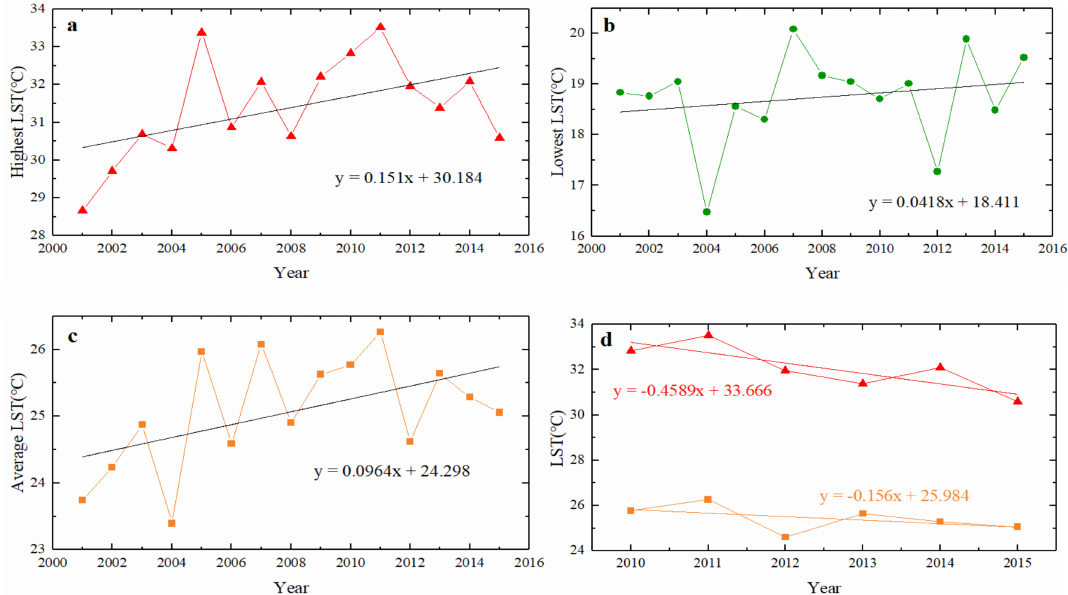
Figure 8. The change of LST ( ◦ C) in Chongqing City. ( a ), ( b , c ) represent the highest, lowest and average LST changes, respectively, from 2001 to 2015. ( d ) represents the changes of highest LST (the red line) and average LST (the orange line) from 2010 to